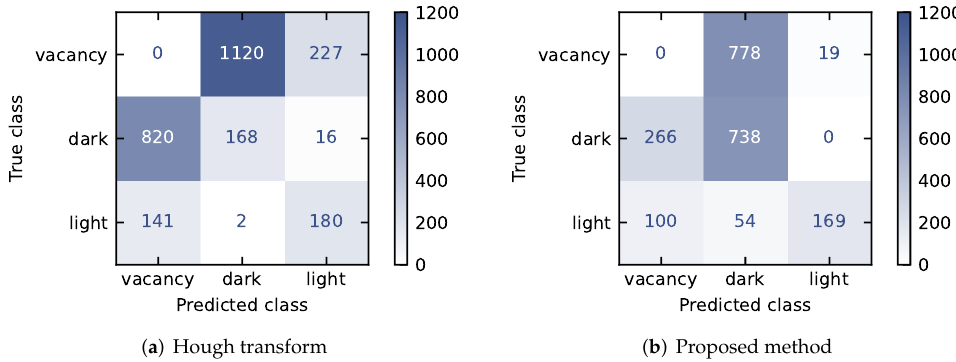
Figure 12. Comparison of confusion matrices of Hough transform ( a ) and proposed method ( b ), when applied to merged manual